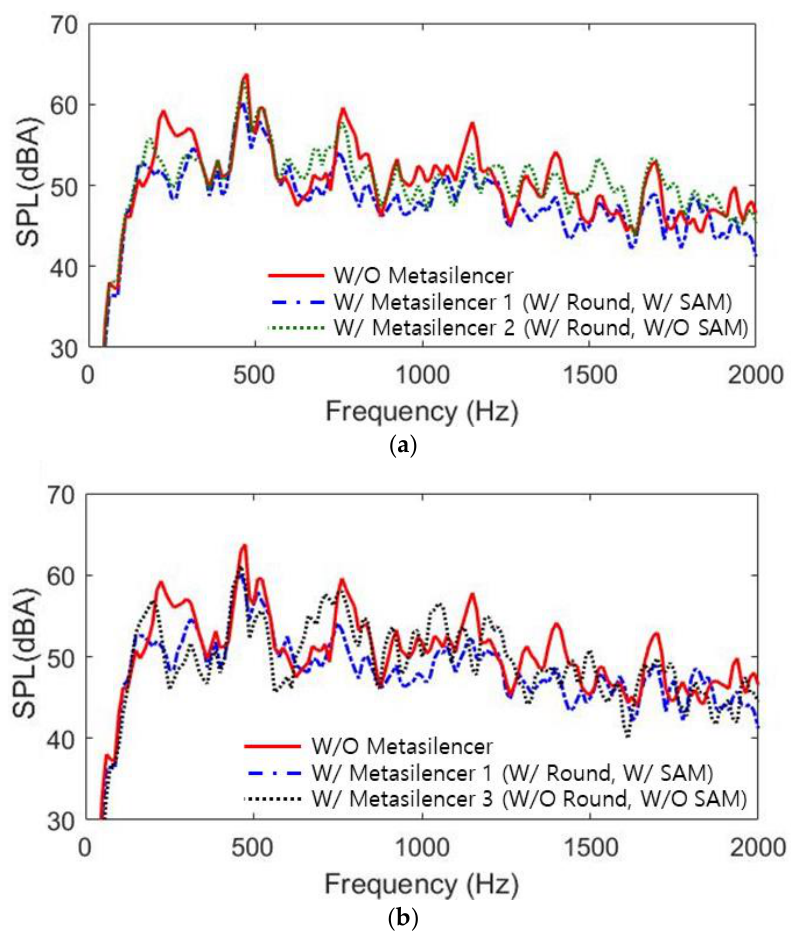
Figure 15. HVAC test results for 13 V voltage applied: ( a ) comparison of effects of metasilencers considering the flow; ( b ) comparison of each effect of a small amount of SAM.